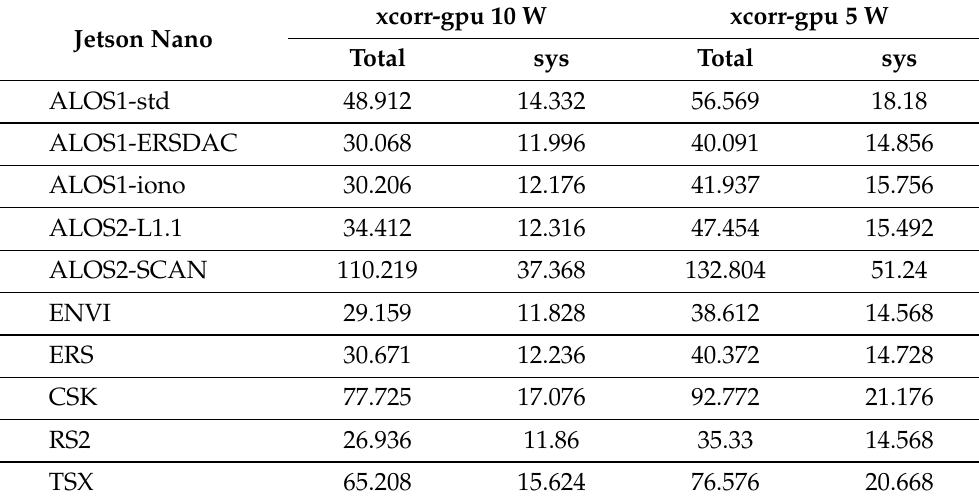
Table 8. Execution times for xcorr-gpu with power mode set on 5 Watts and 10 Watts on Jetson Nano hardware configuration. Figures are expressed in seconds, and the sys column presents the fraction of the total spent in Supervisor mode, also in